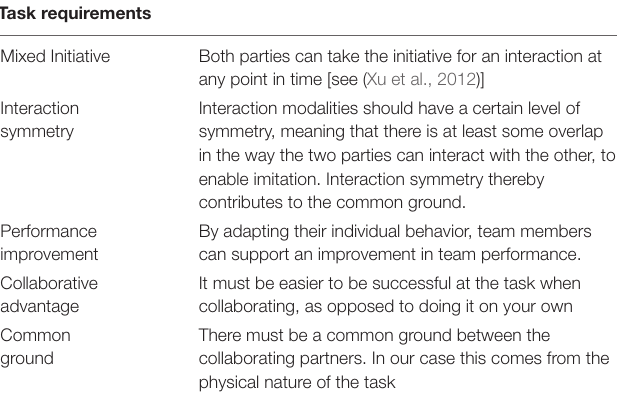
TABLE 2 | Task requirements for a collaborative, co-adaptive task